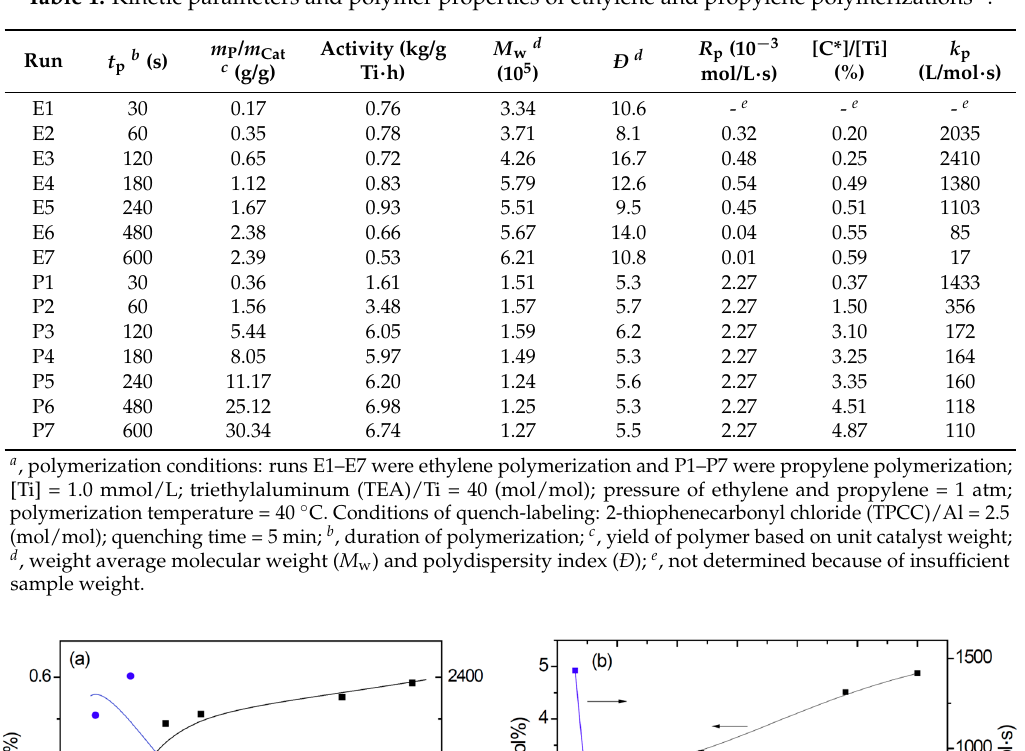
Table 1. Kinetic parameters and polymer properties of ethylene and propylene polymerizations a .